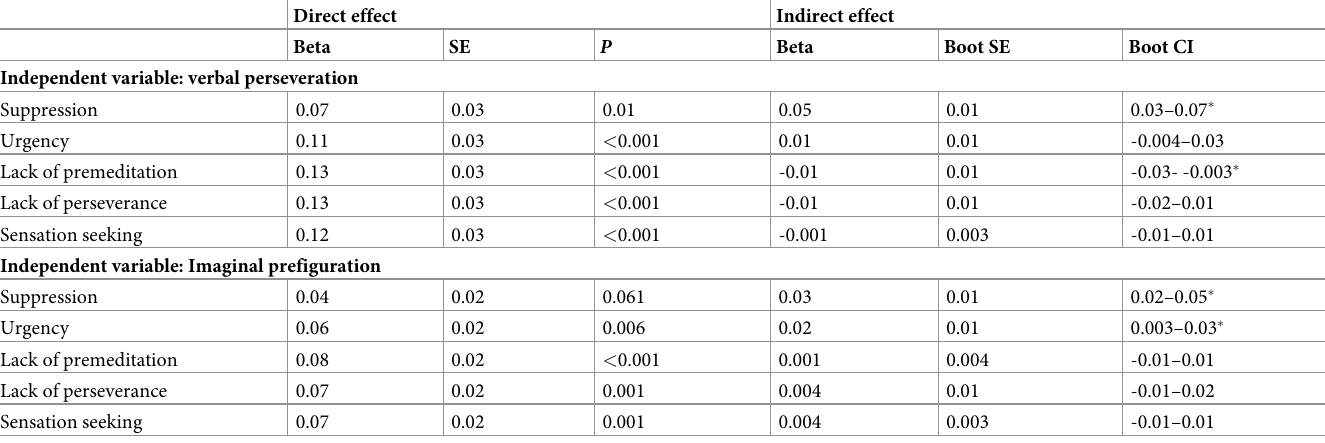
Table 5. Mediation analyses results, taking verbal perseveration / imaginal prefiguration as the independent variables, the impulsivity subscales and the suppression score as mediators and social media use disorder score as the dependent